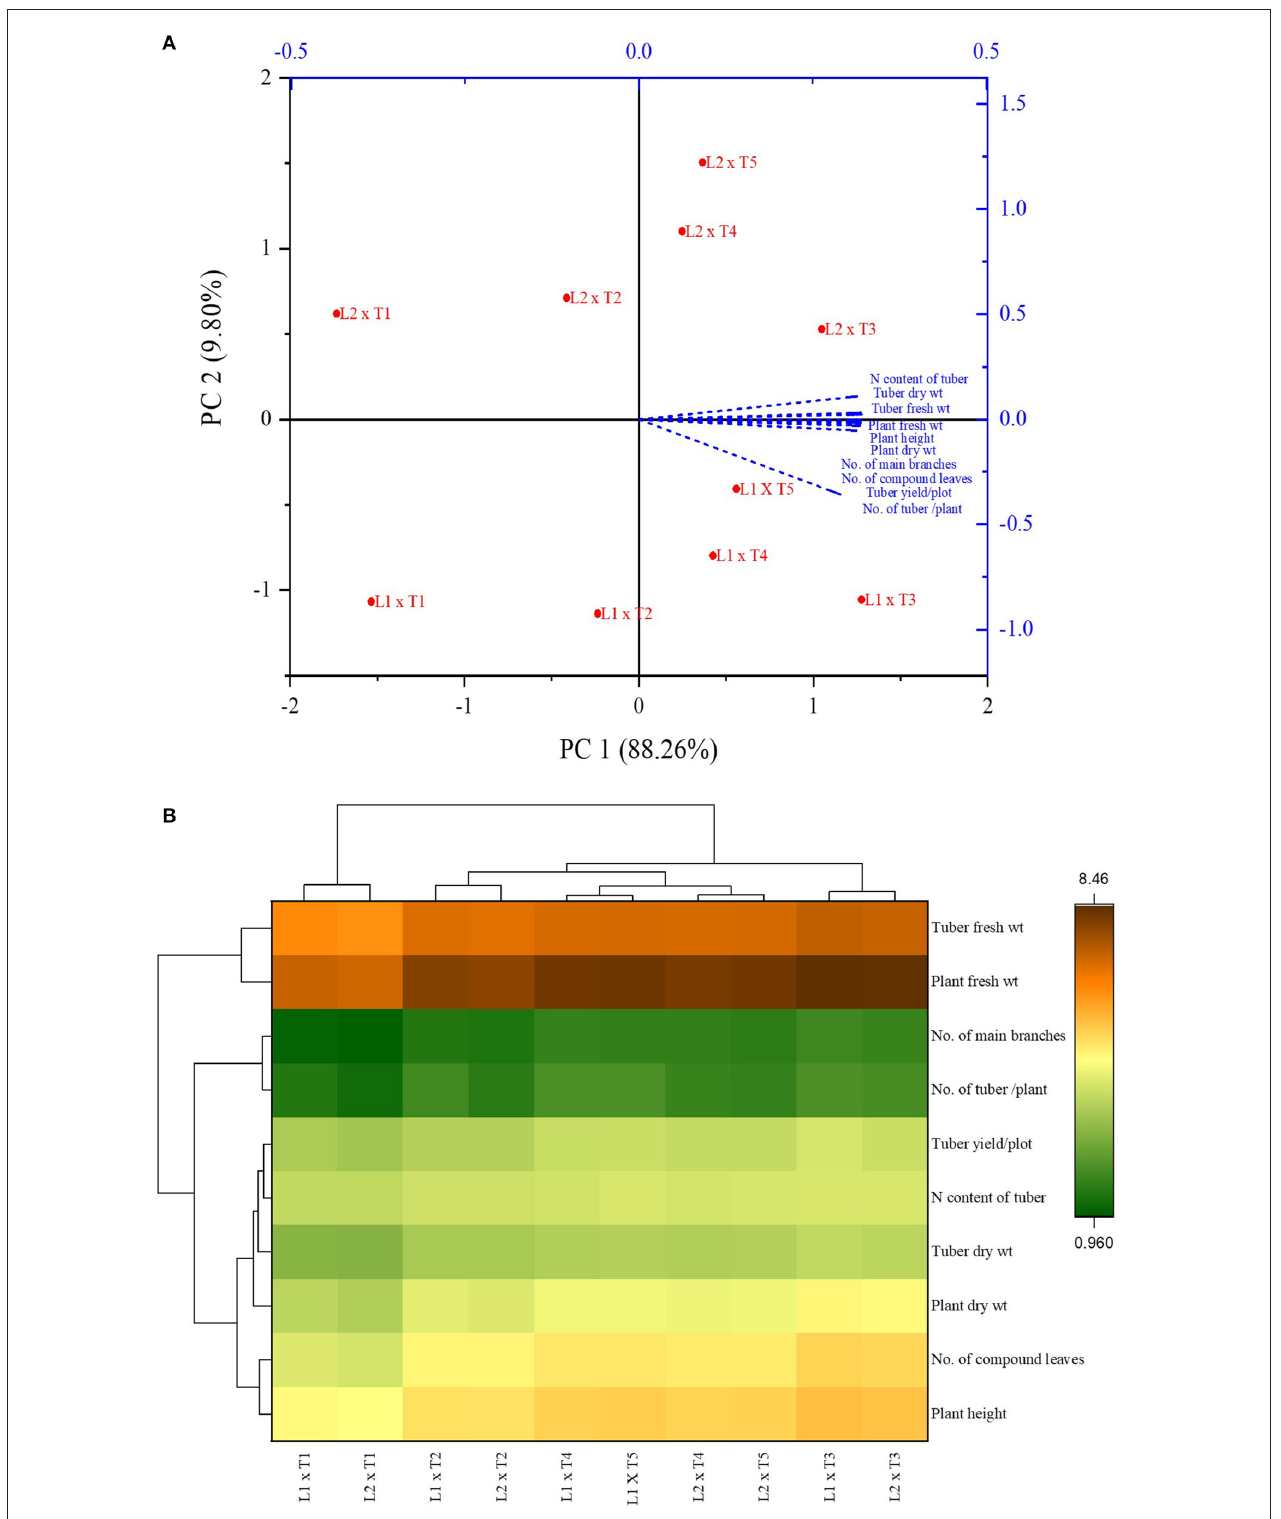
FIGURE 7 | Principal component analysis (A) and Heatmap (B) of Azospirillum spp. strains TN03 and TN09 inoculation response on different agronomic parameters of potato plant grown in Faisalabad and Sahiwal field conditions.